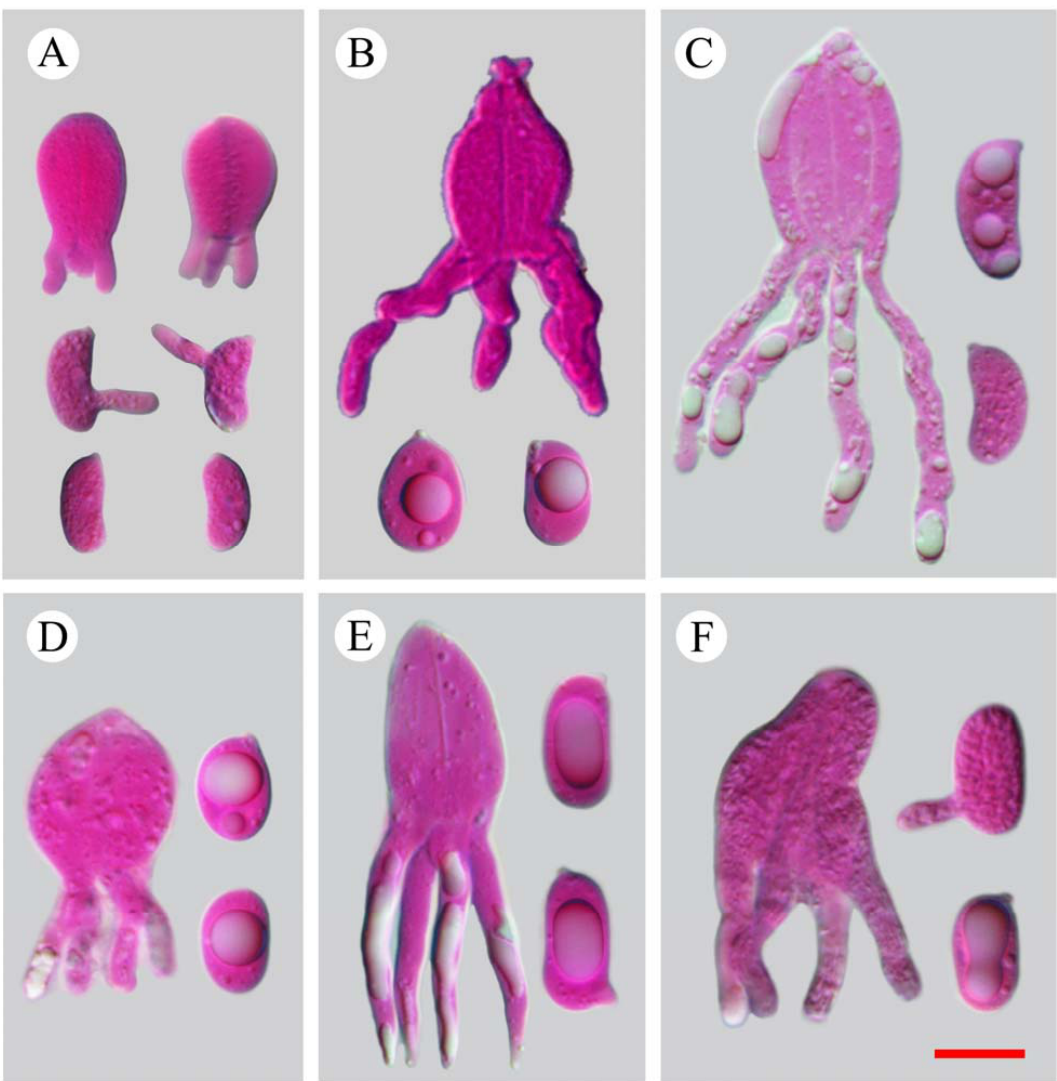
Figure 5. Micrographs of basidia and basidiospores (in phloxine and KOH). Scale bar = 10 µ m. ( A ). Heterocorticium bambusicola (holotype, He 4236, BJFC 023678); ( B ). Heterocorticium latisporum (holotype, He 20120923 ‐ 20, BJFC 014667); ( C ). Eichleriella alpina (holotype, He 20120916 ‐ 1, BJFC 014581); ( D ). Eichleriella bambusicola (holotype, He 4073, BJFC 023514); ( E ). Heteroradulum maolanense (holotype, He 4773, BJFC 024290); ( F ). Heteroradulum labyrinthinum (He 20120722 ‐ 1, BJFC 014502).